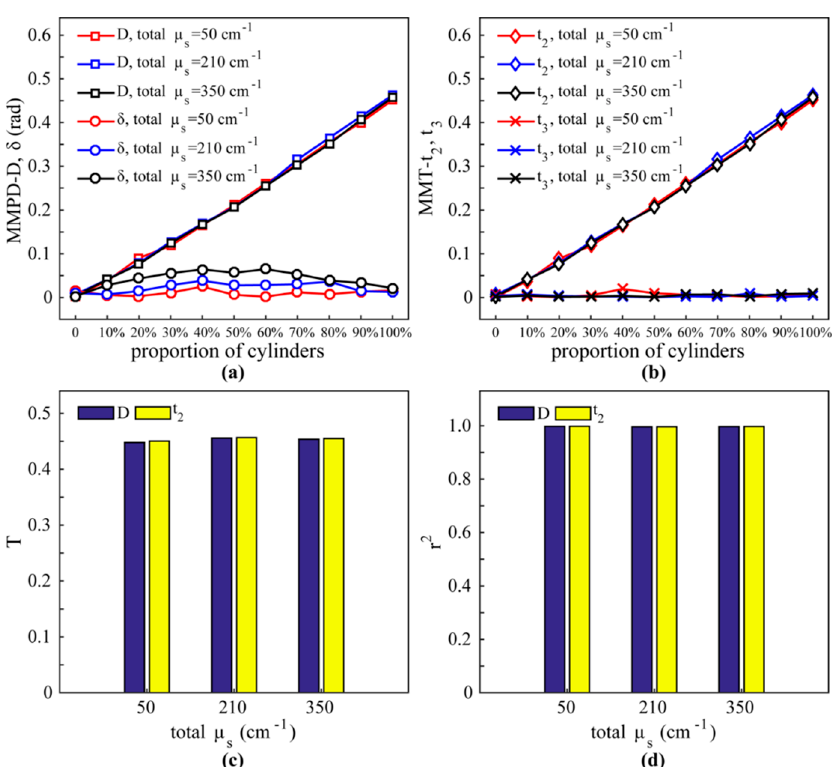
Figure 5. MC simulation results of sphere-cylinder model in backward direction: ( a ) MMPD parameters D and δ . ( b ) MMT parameters t 2 and t 3 . ( c ) T of D and t 2 ; the codomains of D and t 2 are [0,1]. ( d ) The r 2 of D and t 2 .